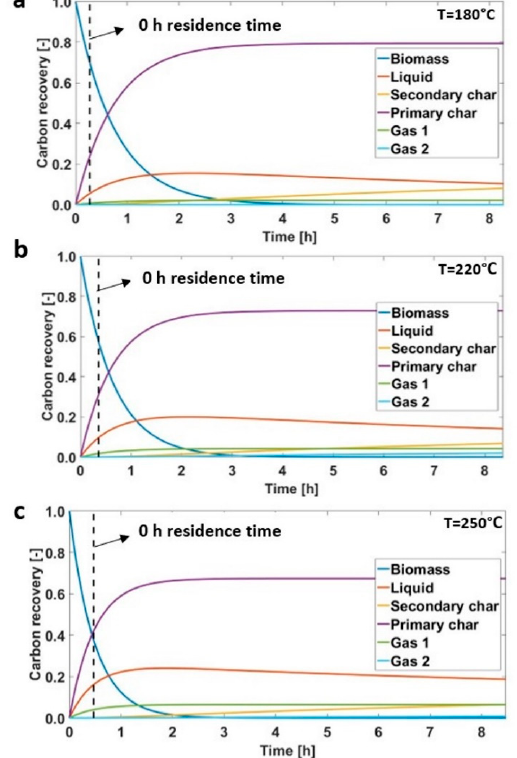
Figure 4. Carbon recovery in solid and gas for olive trimmings: ( a ) 180 °C, ( b ) 220 °C, and ( c ) 250 °C.